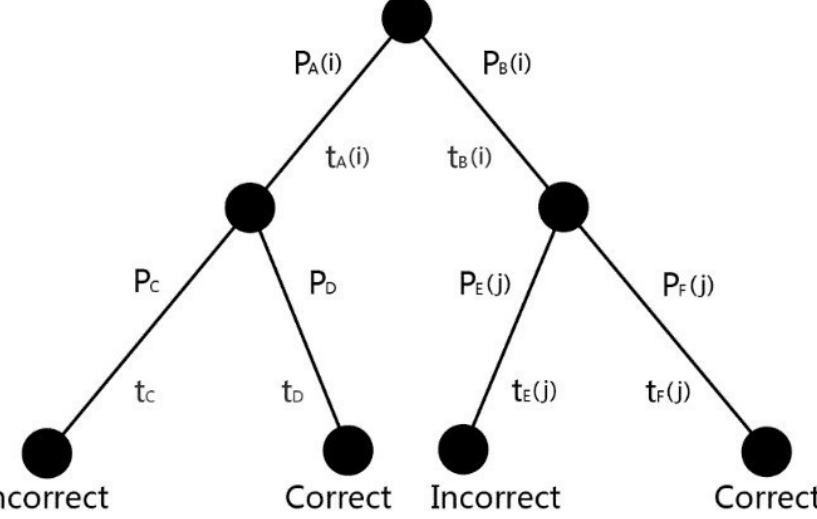
Figure 1. A Multinomial Processing Tree. It is the Standard Binary Tree for Ordered Processes. A probability denoted by P labels each arc, also a measure denoted by t . See text for further notation.